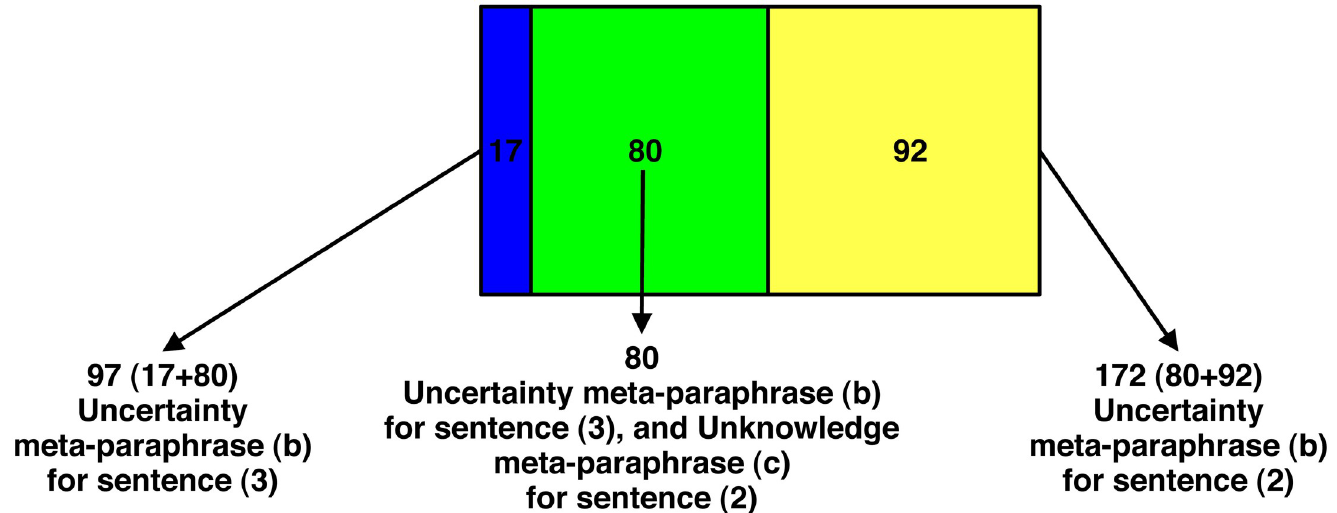
Fig 10. Participants who selected the uncertainty EMP for sentence (3) and the unknowledge EMP for sentences (2). � The green section of the figure (i.e., the overlap area) refers to the subjects who assigned the EMP (b) to sentence (3) and EMP (c) to sentence (2); the blue section of the figure refers to the subjects who assigned the EMP (b) to sentence (3); the yellow section refers to the subjects who assigned the EMP (b) to sentence (2).